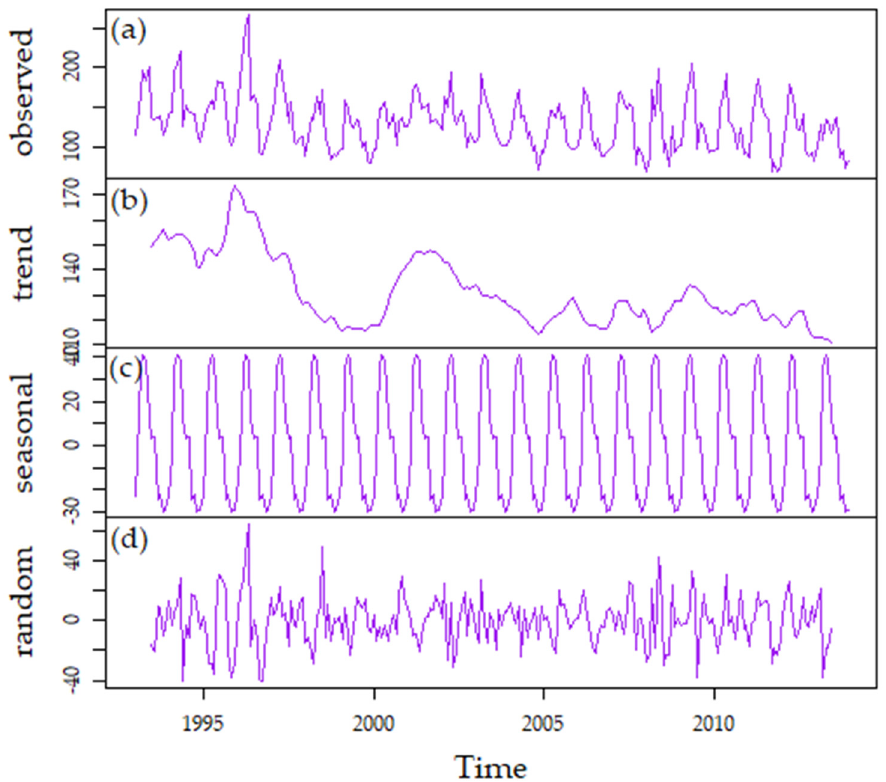
Figure 5. Decomposition of additive time series of monthly evaporation values recorded at the SMN weather station 21052 (1993 to 2013). The observed data is represented in the upper panel ( a ), while the next panels show the additive components [( b ) long-term trend, ( c ) seasonal, and ( d ) random components].